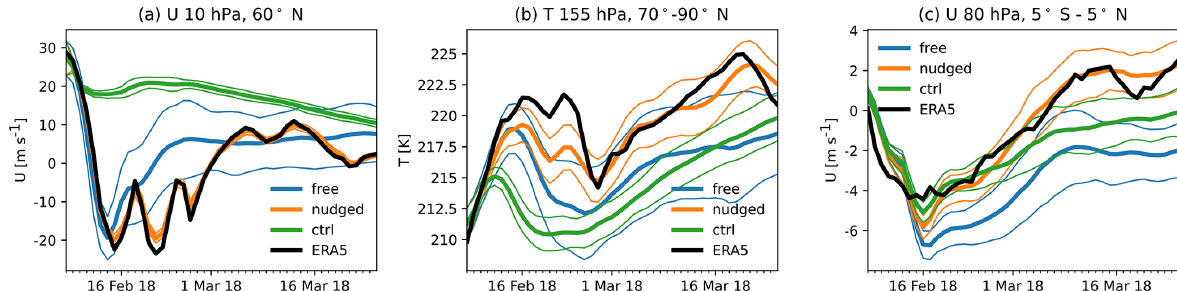
Figure 3. Evolution of zonal-mean U and T in several regions indicated in the captions for free , nudged , and control forecast ensembles produced by the CESM2 model. Forecasts are initialized at 12 February 2018; the forecast ensembles consist of 50 members. The thick lines indicate the ensemble mean, and the thin lines indicate the ensemble spread (1 standard deviation). Solid black lines show ERA5 output.